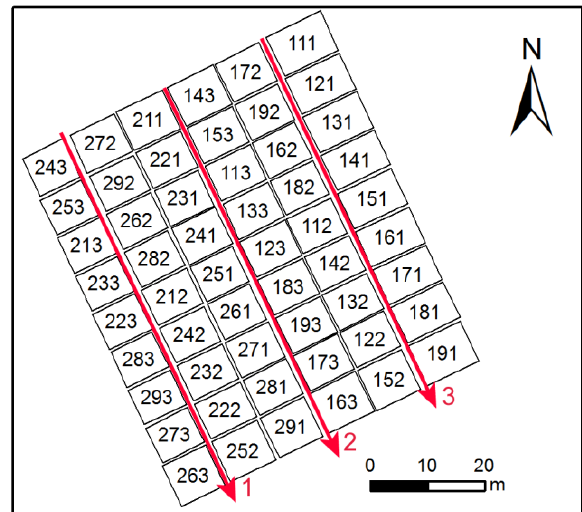
Figure 2. Experiment field in Keyansuo, plot numbering: 1 st no.: cultivar (1=Kongyu131, 2=Longjing21), 2 nd no.: treatment (1=0, 2=70, 3=100, 4=130, 5=160 kg ha -1 , 6-9=other), 3 rd no.: replication, red arrows: flight strips 1-3.